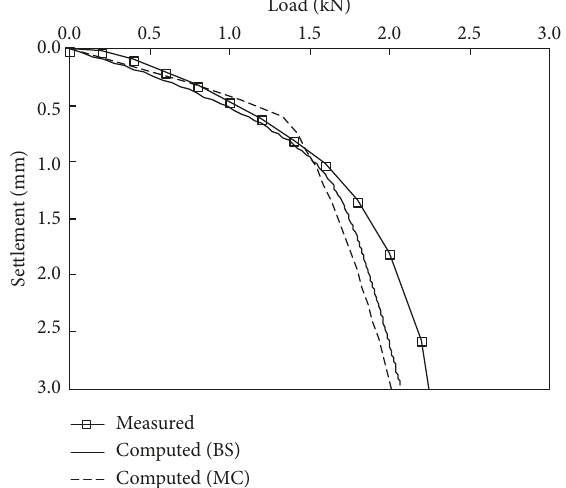
Figure 4: Load-settlement